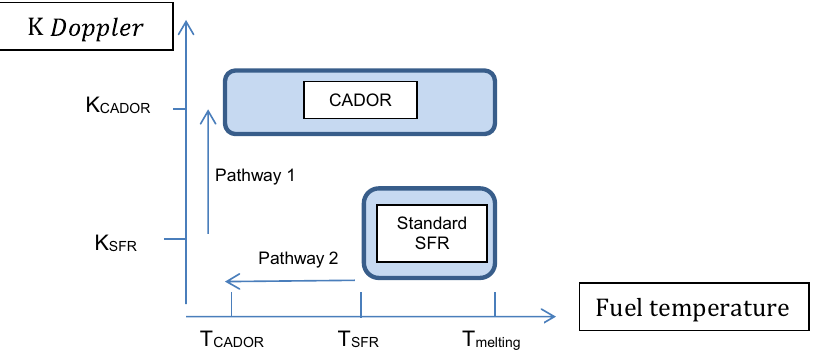
Fig. 3. CADOR operating domain compared to